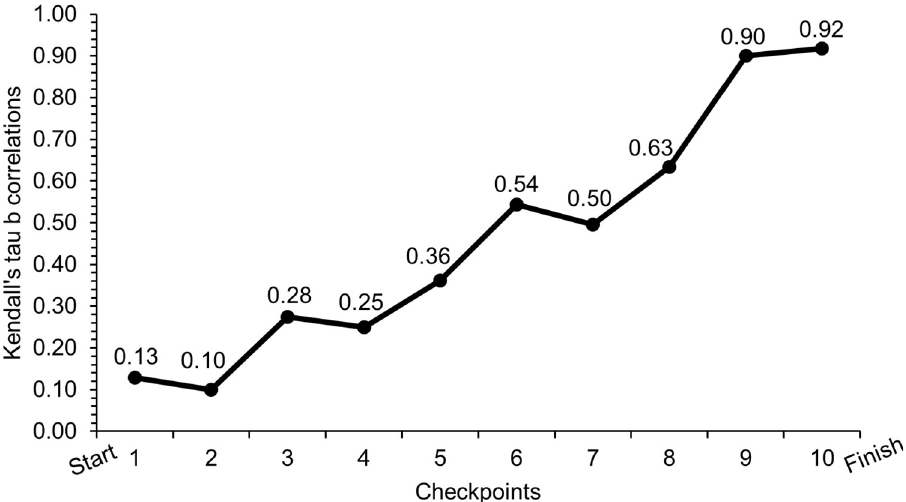
Fig 2. Kendall’s tau-b correlations. The relationship between intermediate ranks and final rank during the heats of a classical sprint cross-country skiing race for elite male skiers [N = 30].